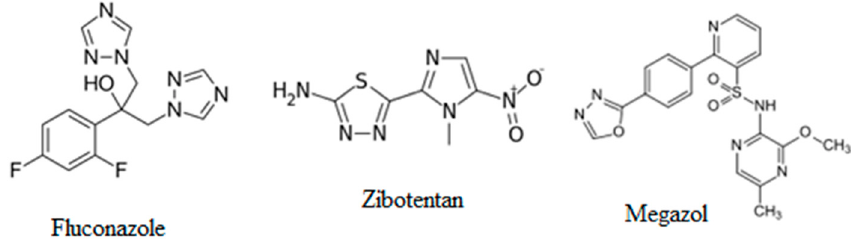
Figure 1. Active substances containing 1,2,4-triazole, 1,3,4-thiadiazole and 1,3,4-oxadiazole scaffold.